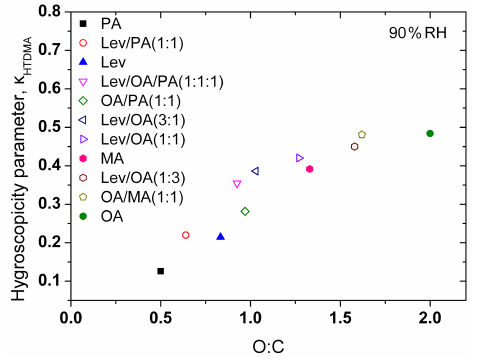
Figure 12. The κ results derived from HTDMA measurements at 90%RH for aerosols containing oxalic acid (OA) and levoglucosan (Lev) in varying mass proportions. ZSR-predicted κ values are also shown by assuming liquid oxalic acid dihydrate or liquid anhydrous oxalic acid in the initial mixtures under dry conditions. The κ value of oxalic acid is obtained from the